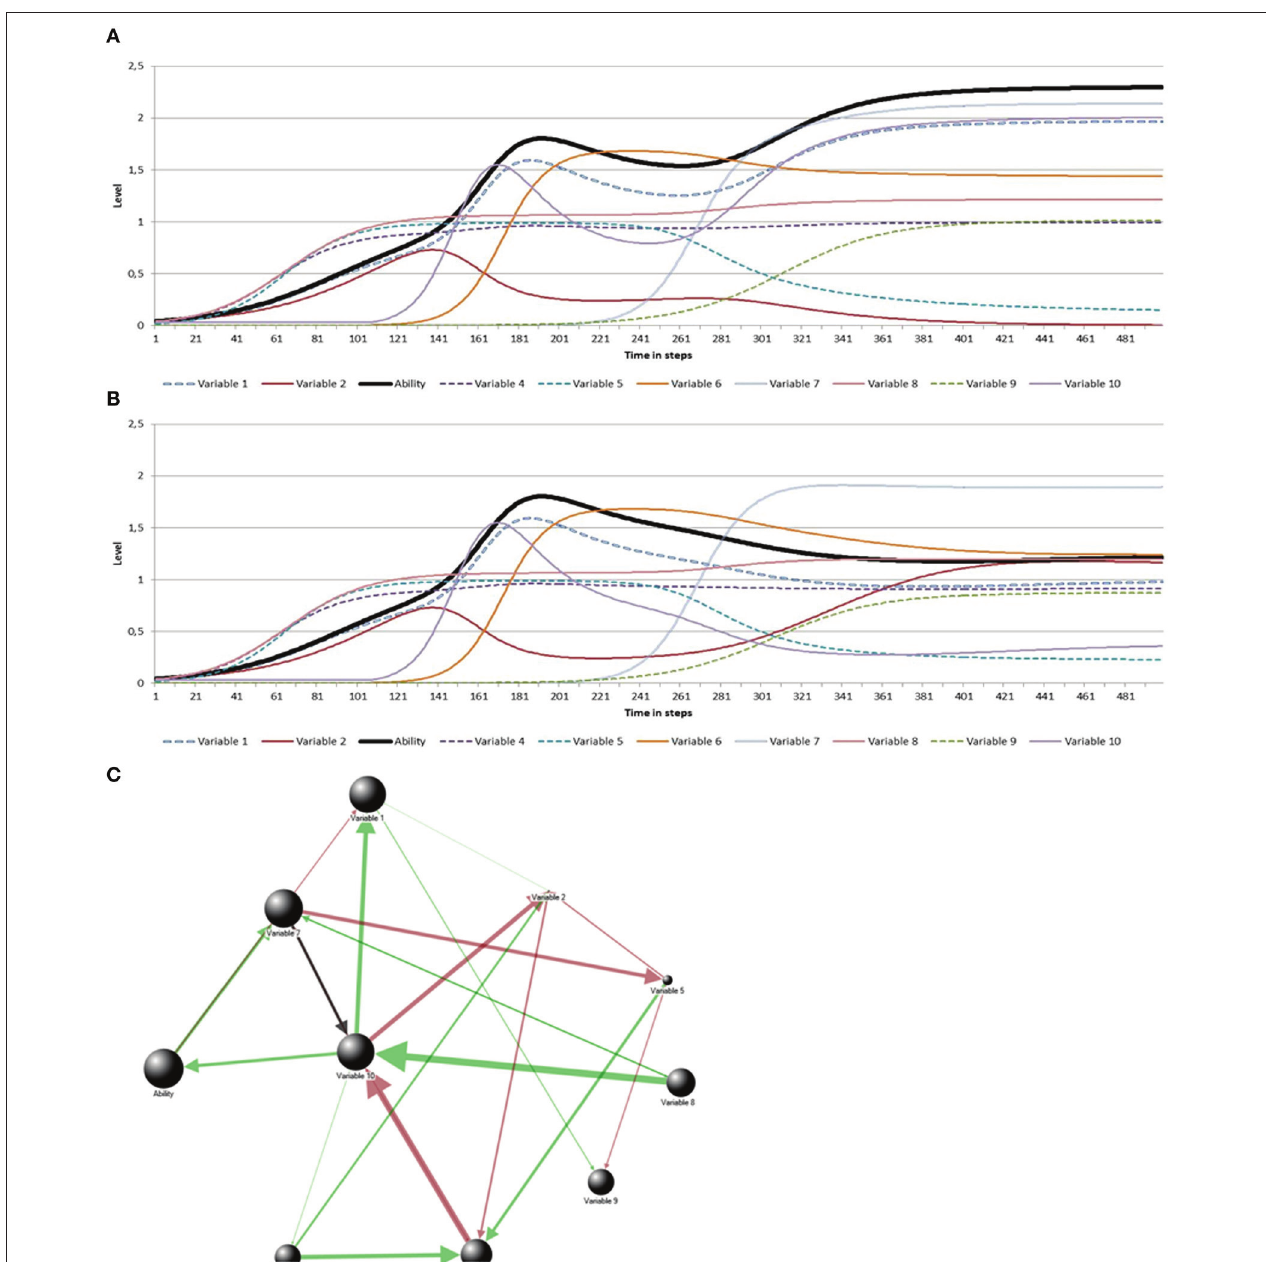
FIGURE 7 | Two lifespan trajectories. The difference between the trajectories in Graphs (A,B) is caused by the sign (positive or negative, respectively) of the relationship between variable 7 and variable 10 (black arrow in C ). The parameter values corresponding to the simulations are: Initial ability L = 0.041; Max L = 2.30 (A) and 1.80 (B) ; Rate r = 0.04 (A) and 0.01 (B) ; Genetic factor K = 0.99; and total support = 0.03.